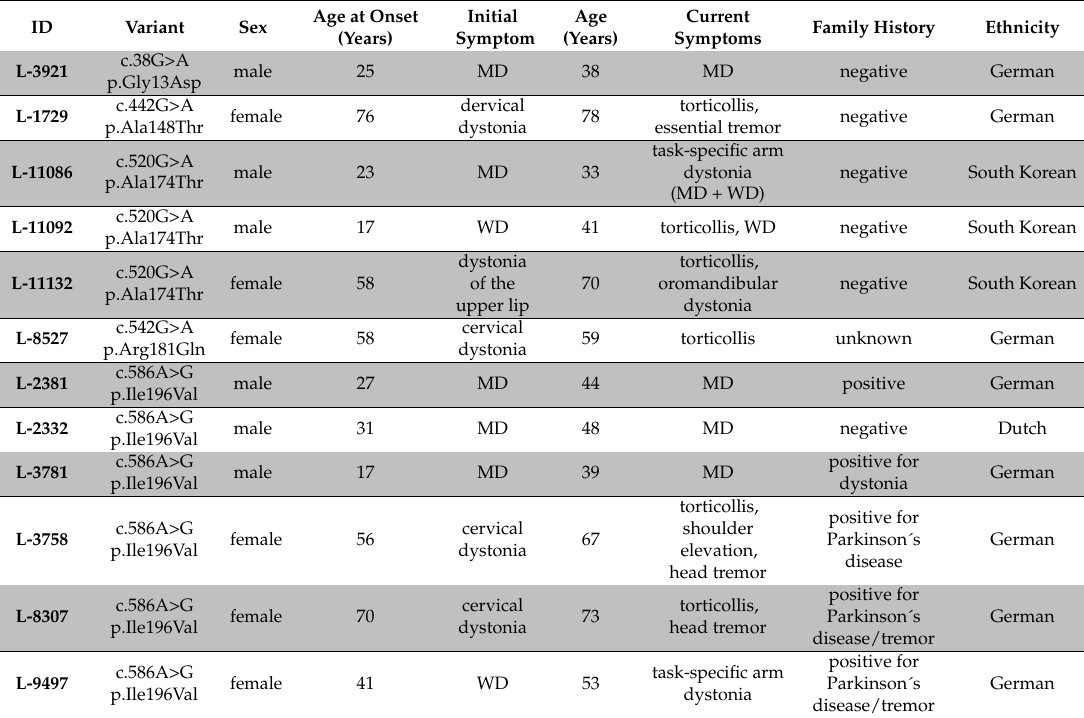
Table 3. Clinical findings in RAB12 mutation